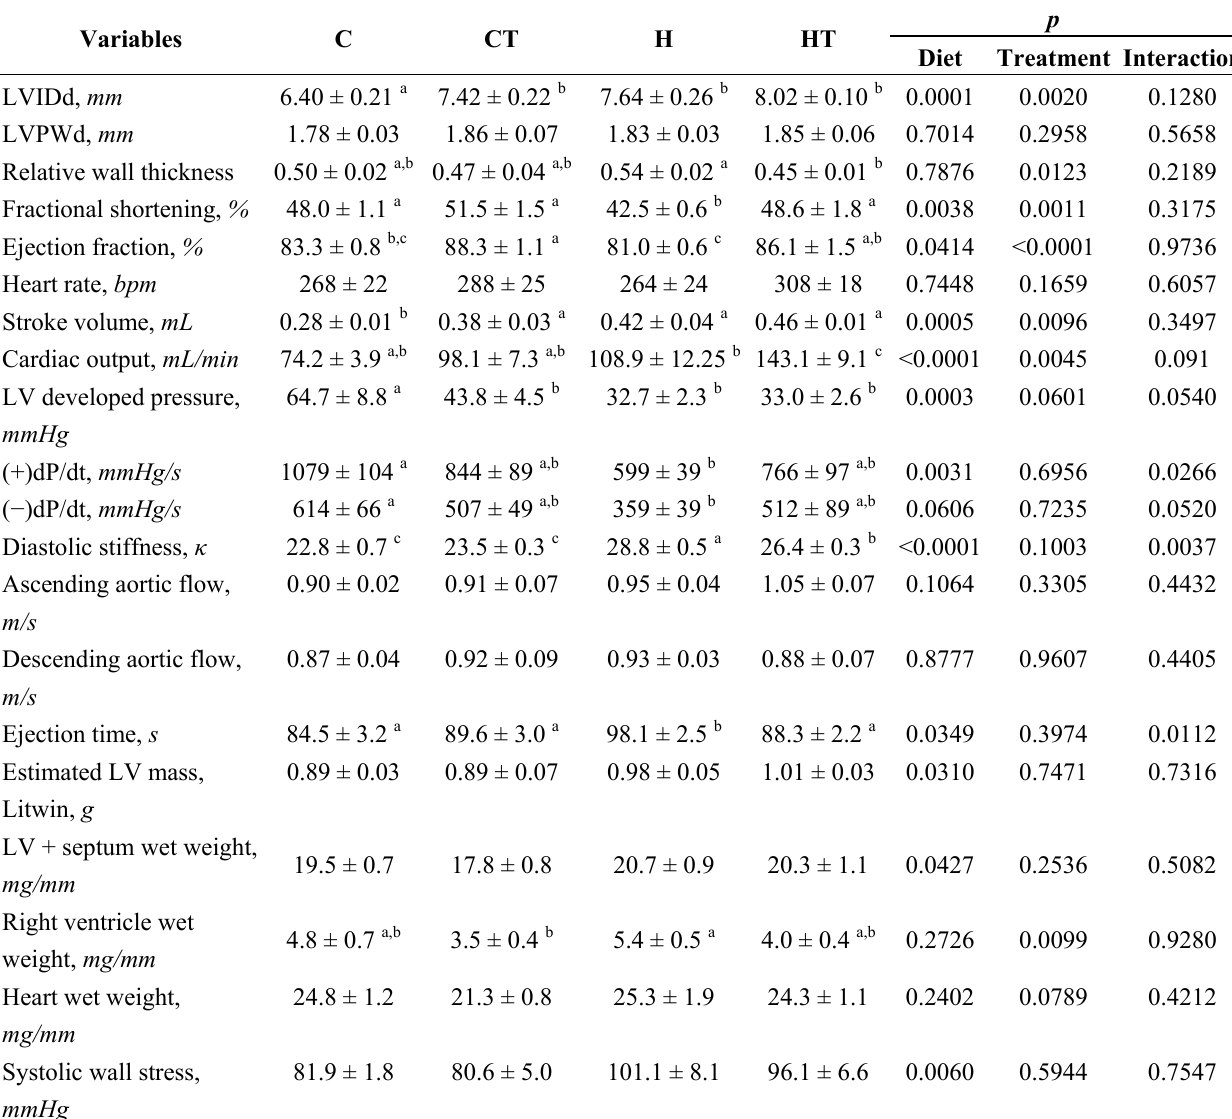
Table 1. Changes in cardiovascular structure and function in C, CT, H and HT diet-fed